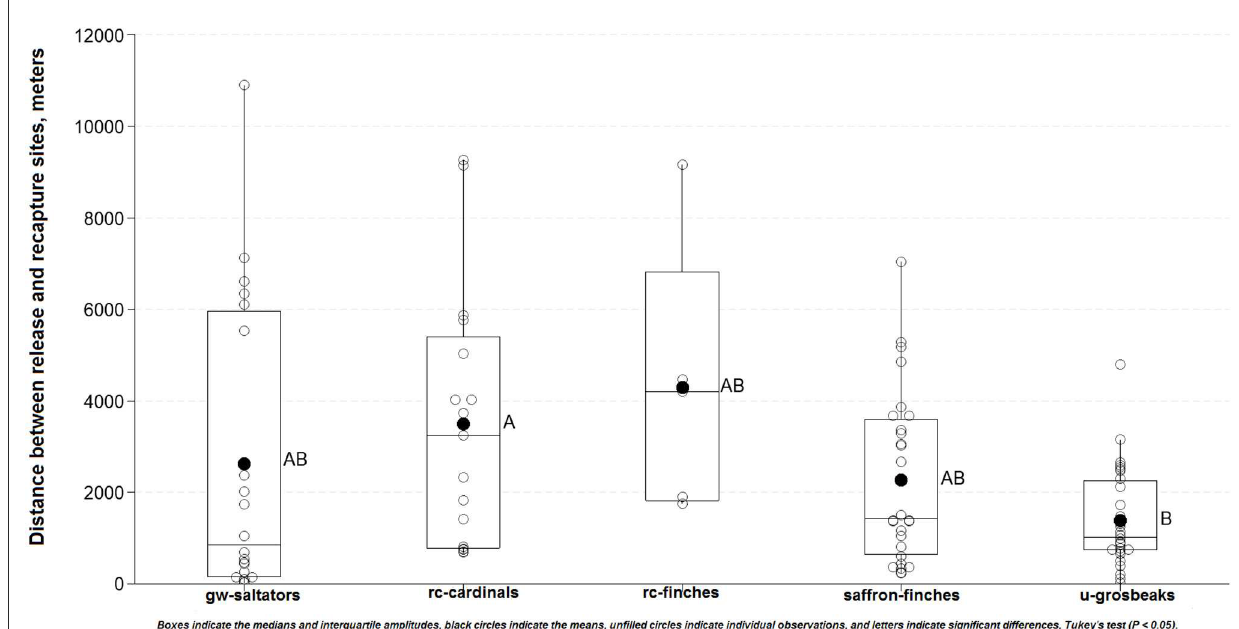
FIGURE2 Distance traveled between release and recapture sites by the songbird species.